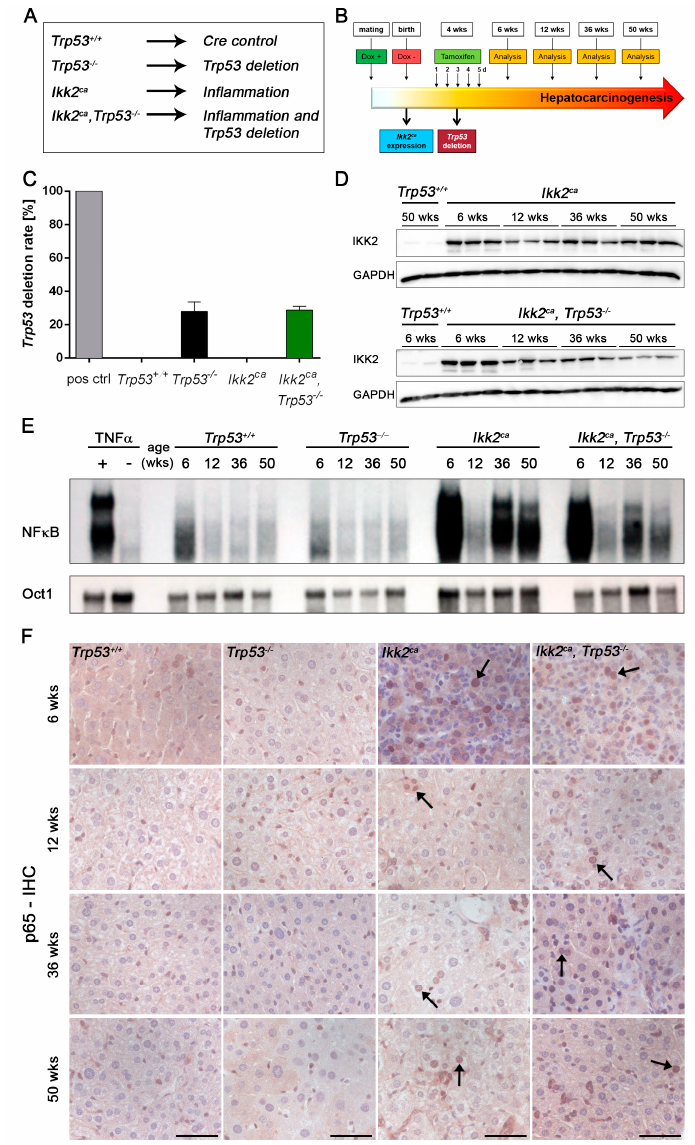
Figure 1. Mouse model of inducible NF- κ B activation and p53 loss. ( A ) Experimental genetic cohorts for the study of the sequence of induced inflammation and p53 loss. ( B ) Experimental study design of liver-specific induction of Ikk2 ca overexpression (Tet-off system) and tamoxifen-induced deletion of Trp53 (Cre-loxP system). Analyses of experimental cohorts were performed at the age of 6, 12, 36, and 50 weeks to study inflammation and subsequent induction of liver fibrosis and tumor formation. ( C ) Bar graph represents the amount of Trp53 deletion in whole liver DNA from 36 weeks old Trp53 − / − ( n = 3) and Ikk2 ca Trp53 − / − mice ( n = 4). As control whole liver DNA from Trp53 +/+ ( n = 3) and Ikk2 ca ( n = 3) mice, and a positive control from a Trp53 deleted primary cell line was used. Data represent the mean ± SD. ( D ) Western blots showing IKK2 expression of whole liver lysates from Ikk2 ca and Ikk2 ca Trp53 − / − mice at the age of 6, 12, 36, and 50 weeks. Whole liver lysates from 6 and 50 weeks old Trp53 +/+ mice were used as control. ( E ) Electrophoretic mobility shift assay (EMSA) depicting NF- κ B activation and control (Oct1) of nuclear extracts from the liver of Trp53 +/+ , Trp53 − / − , Ikk2 ca and Ikk2 ca Trp53 − / − mice at the age of 6, 12, 36, and 50 weeks. As control nuclear extracts from the liver of TNF α injected versus NaCl injected Trp53 +/+ mice were used. ( F ) Representative photographs of p65 immunohistochemistry (IHC) of liver tissue from Trp53 +/+ , Trp53 − / − , Ikk2 ca and Ikk2 ca Trp53 − / − mice at the age of 6, 12, 36, and 50 weeks (scale bar: 50 µ m). Arrows point at p65 positive